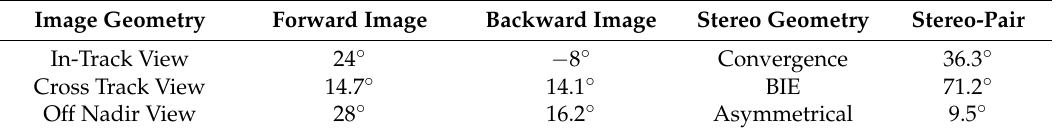
Figure 3. WordView-2 stereo-pair acquired on 20 September 2015: ( A ) forward image, ( B ) backward image. Imagery © 2015, DigitalGlobe, Inc. Table 3. Image and stereo-pair geometry.